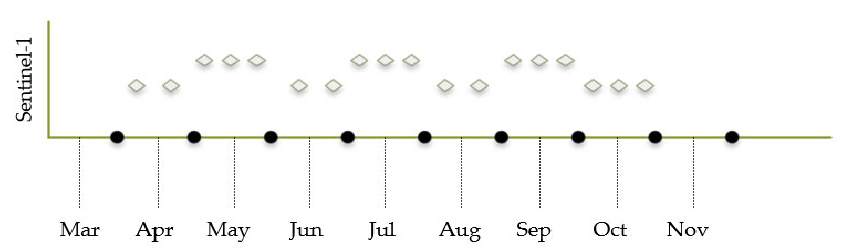
Figure 3. Acquisition Date of Sentinel ‐ 1 products.